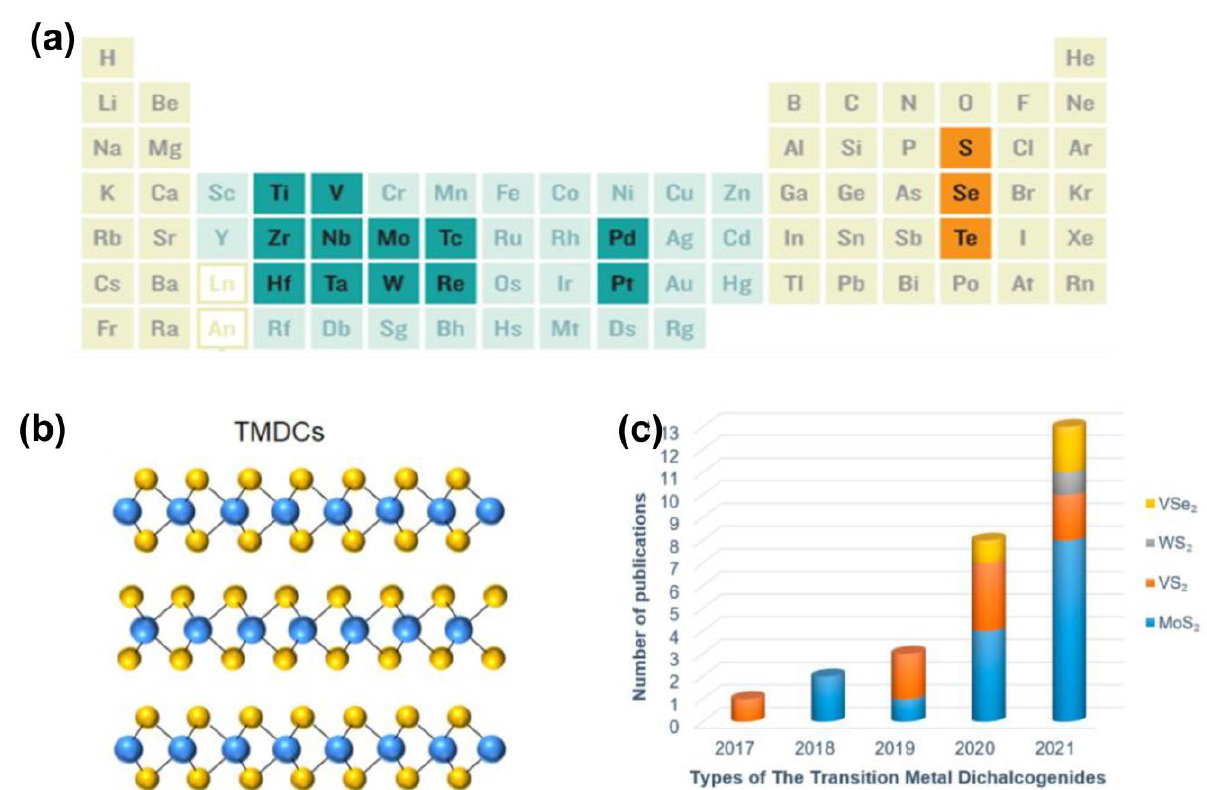
Figure 1. Structure of TMD materials. ( a ) Chemical elements composition of TMD materials. ( b ) Three − dimensional atomic structures of typical TMDs. Reprinted with permission from Ref. [19]. Copyright 2021, Springer. ( c ) The trend of publications on TMDs as ZIB cathode materials. Reprinted with permission from Ref. [10]. Copyright 2022, MDPI (Basel, Switzerland).